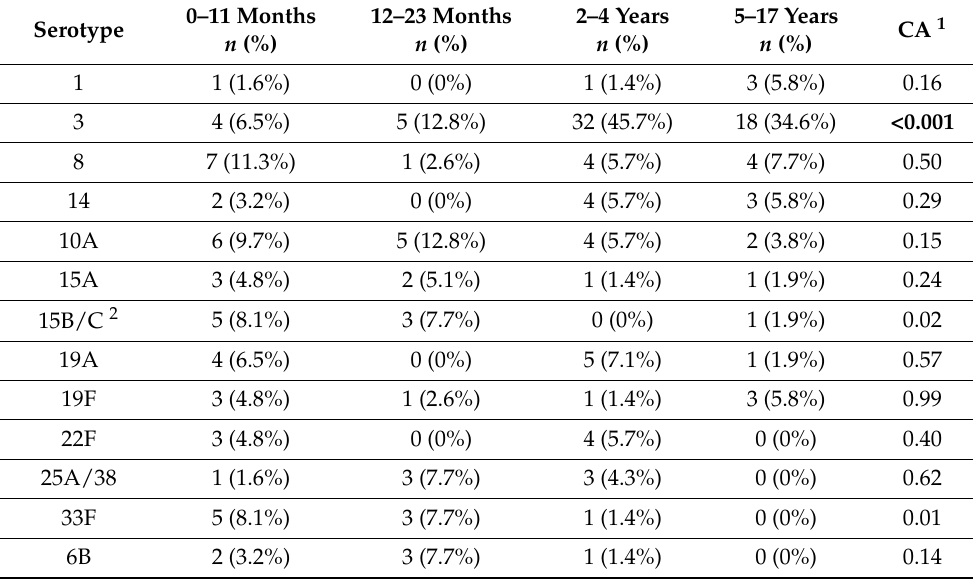
Table 2. Serotype distribution of Streptococcus pneumoniae isolates responsible for invasive disease in patients < 18 years, Portugal, July 2015–June 2018, among the different age groups (for serotypes with n >